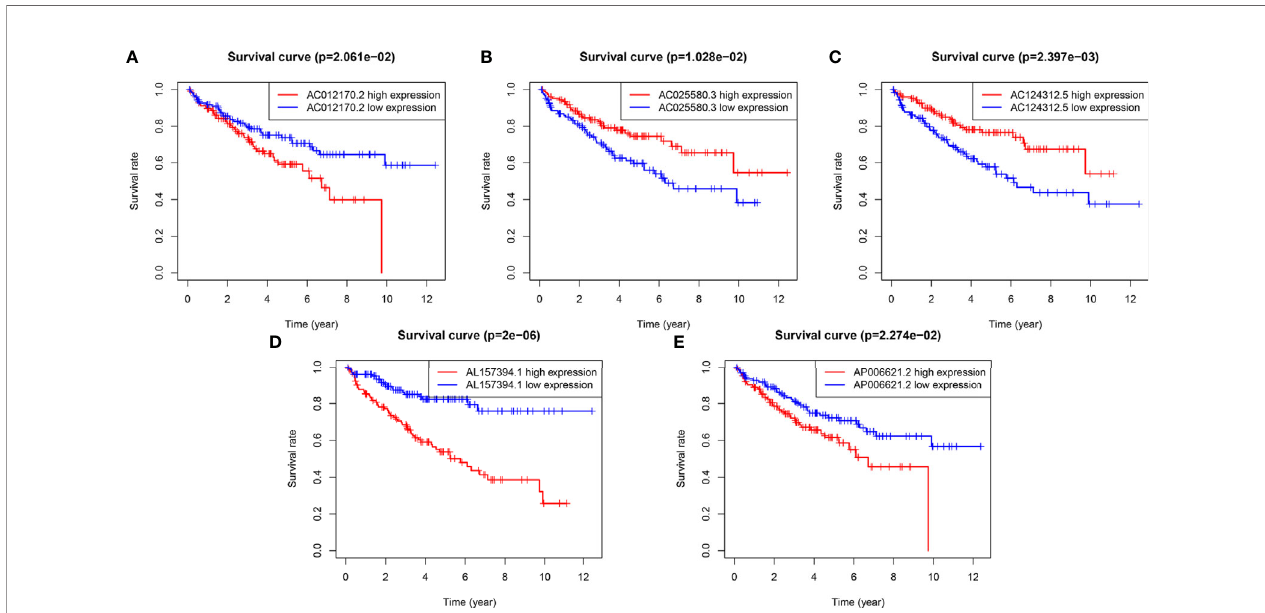
FIGURE 2 | The Kaplan-Meier (K-M) survival curves of fi ve m6A-related lncRNAs in the prognostic signature. (A, D, E) The K-M survival curves of AC012170.2, AL157394.1, and AP006621.2 showed high expression group had worse overall survival (OS) than the low expression group in the training set (p < 0.05). (B, C) The K-M survival curves of AC025580.3 and AC124312.5 showed high expression group had better OS than the low expression group in the training set (p <